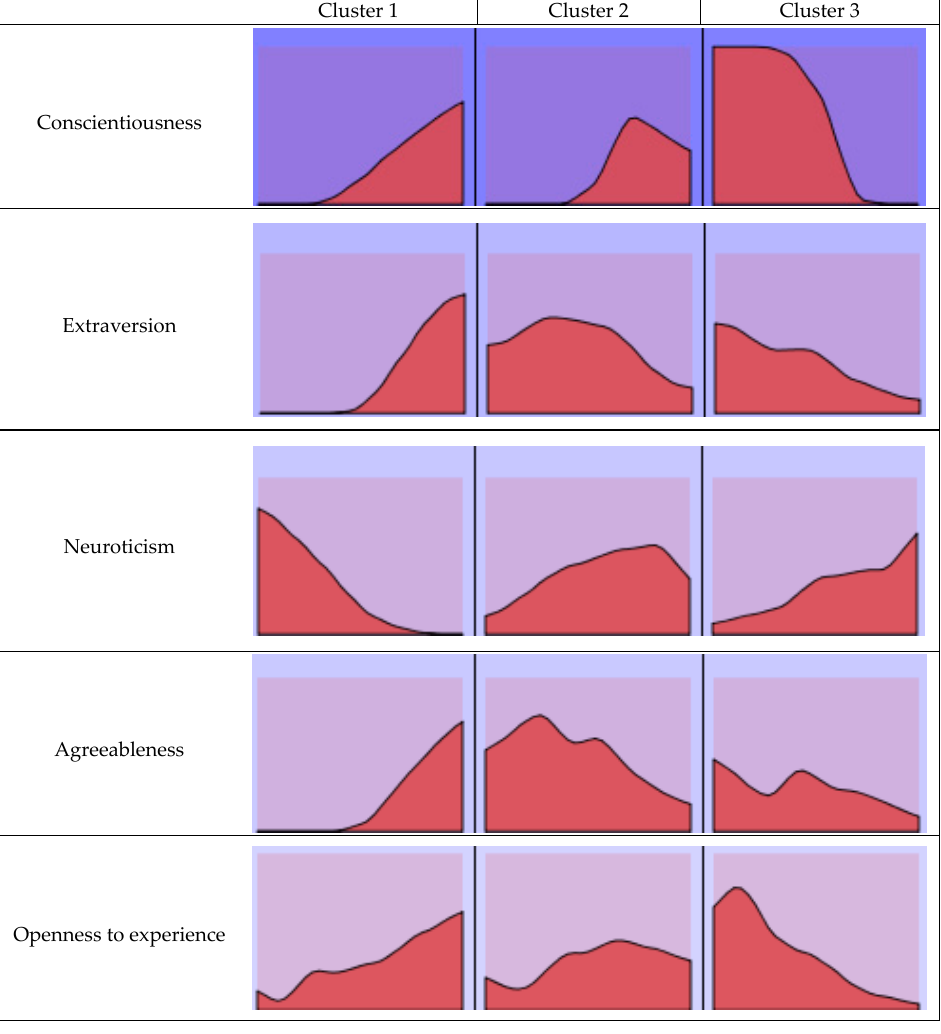
Figure 2. Cluster composition ( N = 1236). The factors were organized in order of importance of input.